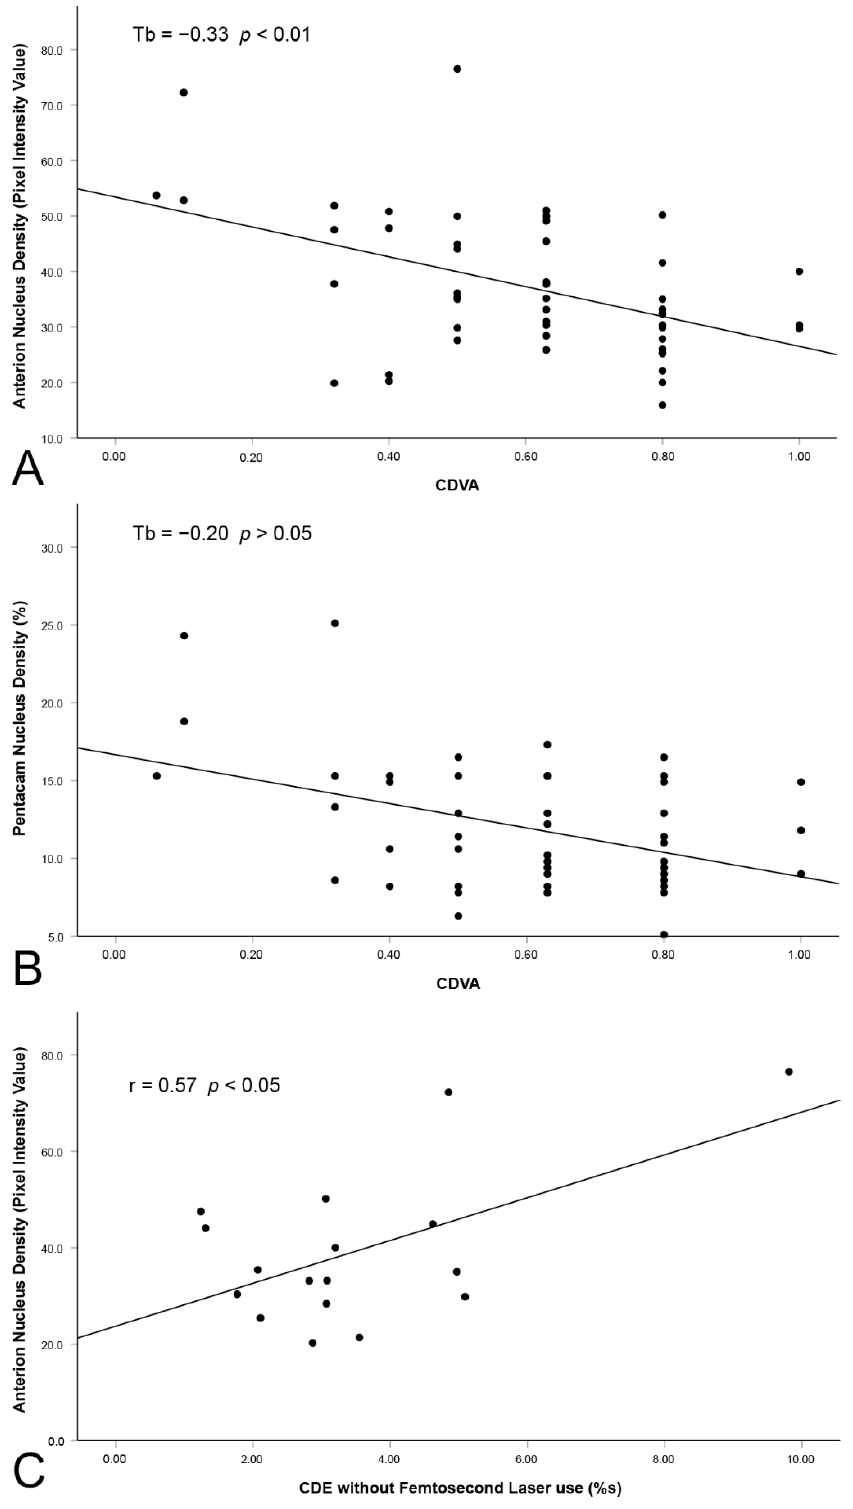
Figure 5. Scatter plots of the correlation between ( A ) nuclear density in SS-OCT and CDVA, ( B ) nuclear density in Scheimpflug imaging and CDVA, and ( C ) lens density in SS-OCT and CDE without femtosecond laser use.